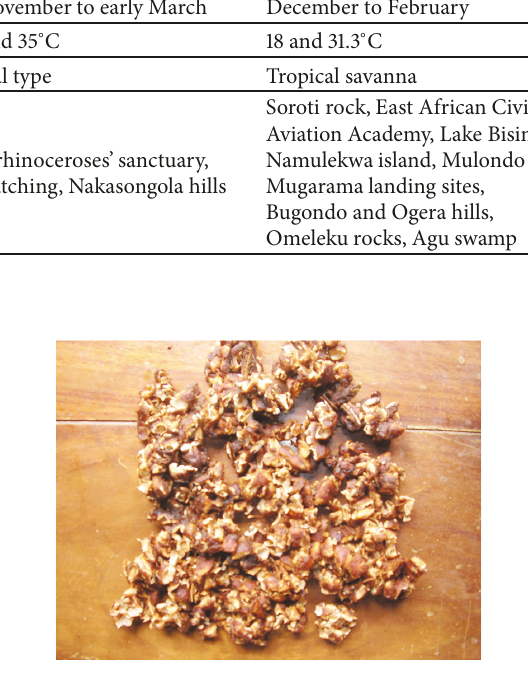
Figure 3: Assorted clean pulp for